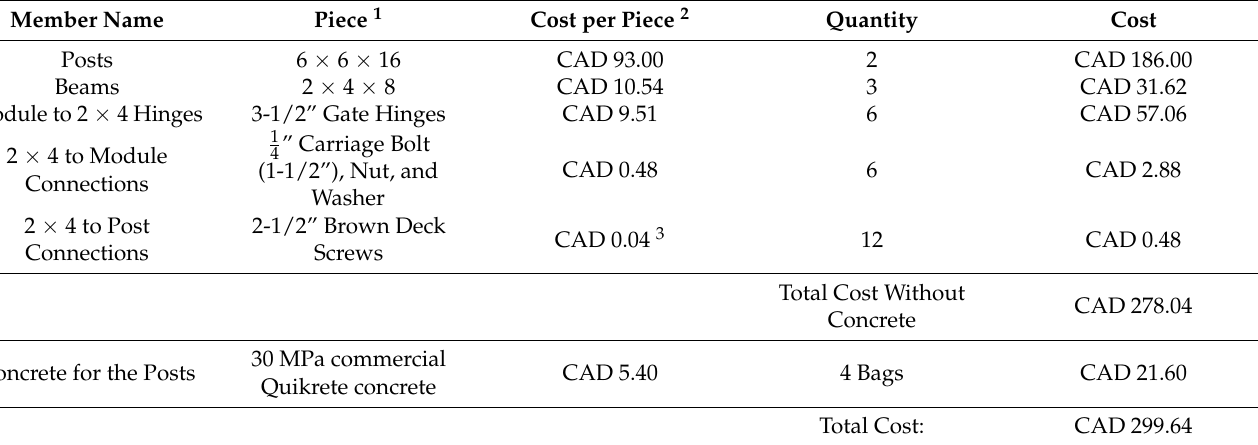
Table 1. List of materials for one section of a